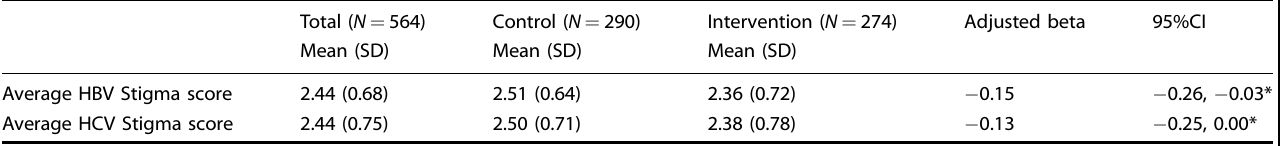
Table 4. Intention-to-treat analysis to evaluate the impact of a crowdsourced intervention on hepatitis stigma among 564 primary care users in urban China, 2019 – 2021.